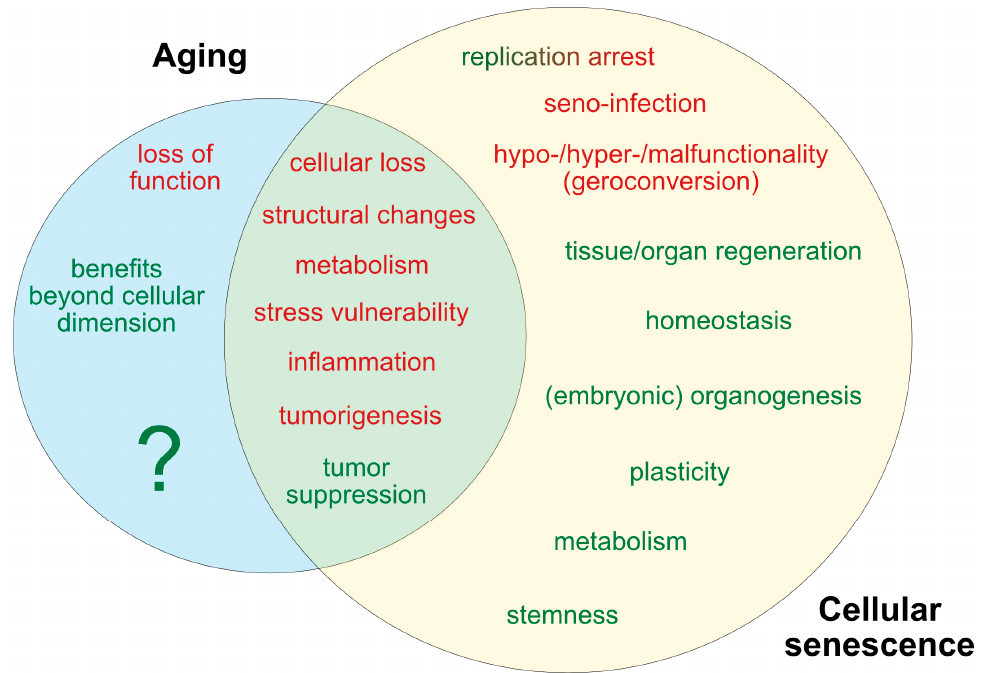
Figure 4. Pathological and beneficial functions of aging and senescence, according to current knowledge. In red are represented pathological consequences and in green beneficial functions of aging and senescence. The impact of aging has mainly been described at the organismal level, since a complete cellular functional profile has not yet been established. Accordingly, whether beneficial consequences of the aging process exist at the cellular level is